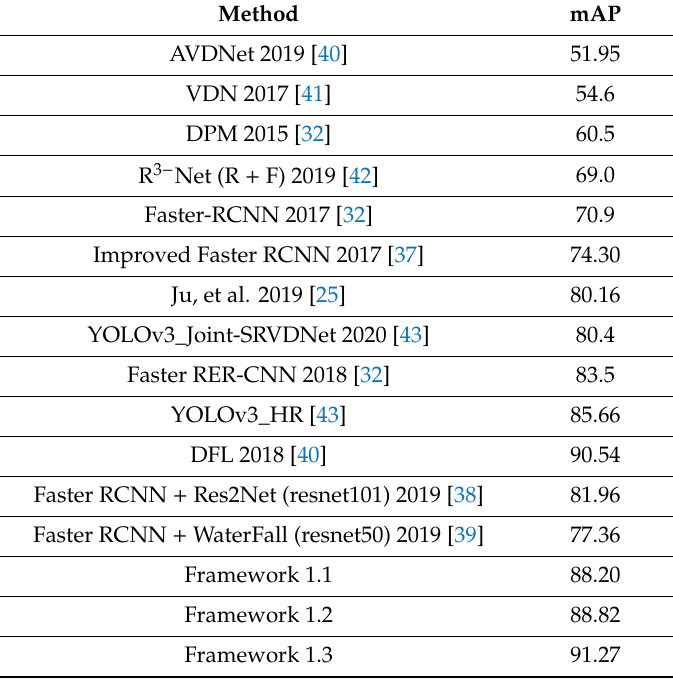
Table 1. Comparison between proposed framework and other methods on